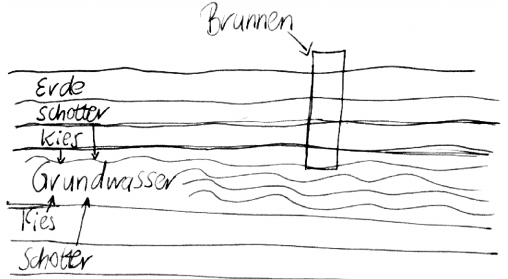
Figure 3. Examples for the categories of analysis. Partially correct representation: the arrows express that the part marked with Grund- wasser (i.e., groundwater) also contains broken stones and gravel; but the aquiclude is missing. Schotter (gravel), Brunnen (well); see caption of Fig. 2 for further translations.